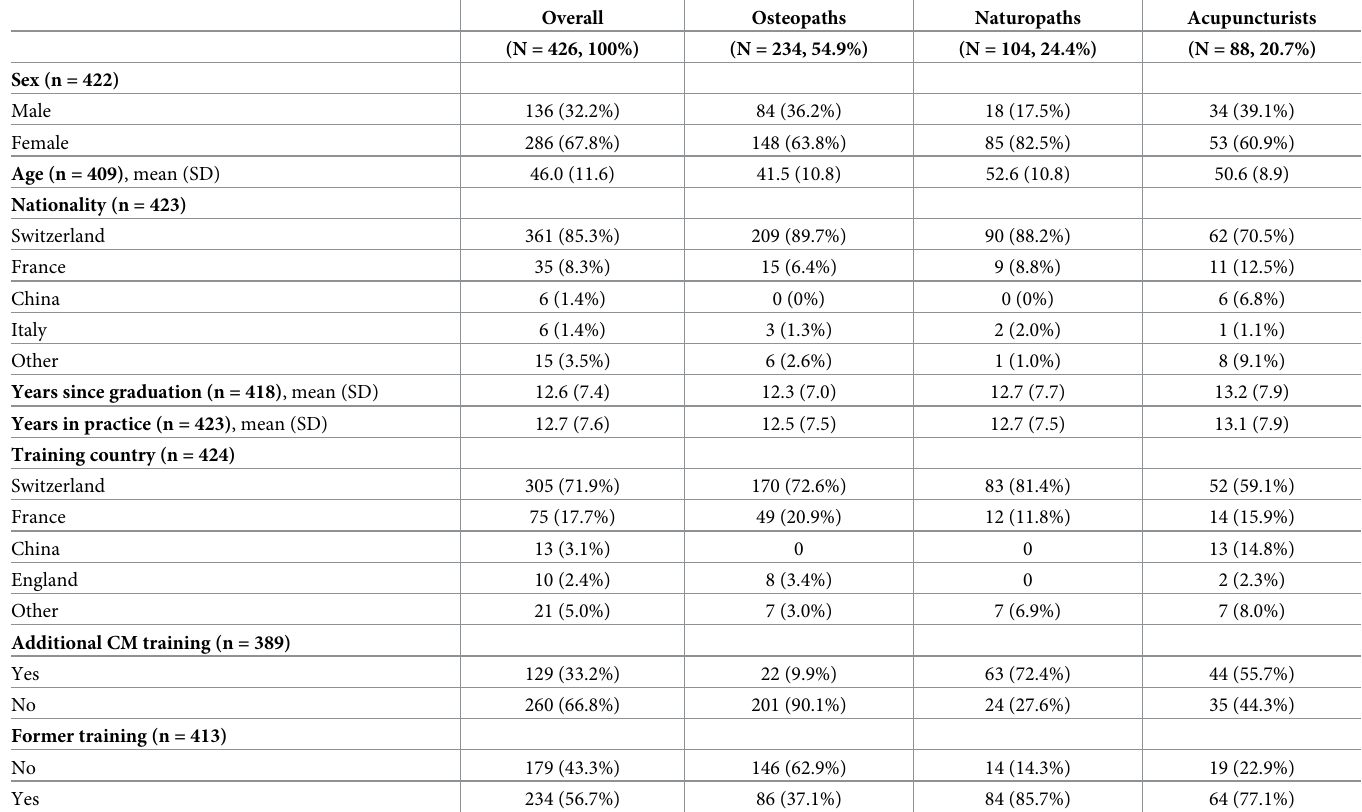
Table 1. Sociodemographic data and training